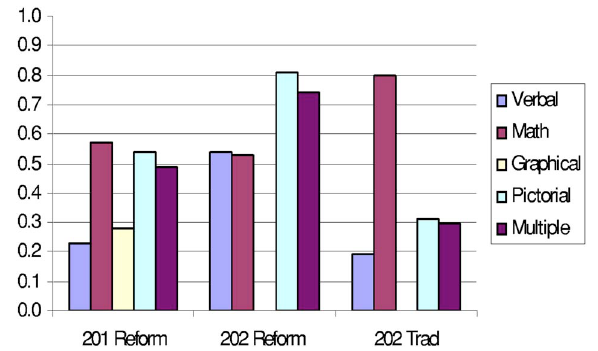
FIG. 5. (cid:1) Color (cid:2) Distribution of representations used in the ex- ams in the three courses studied here. Also includes the fraction of exam representations.